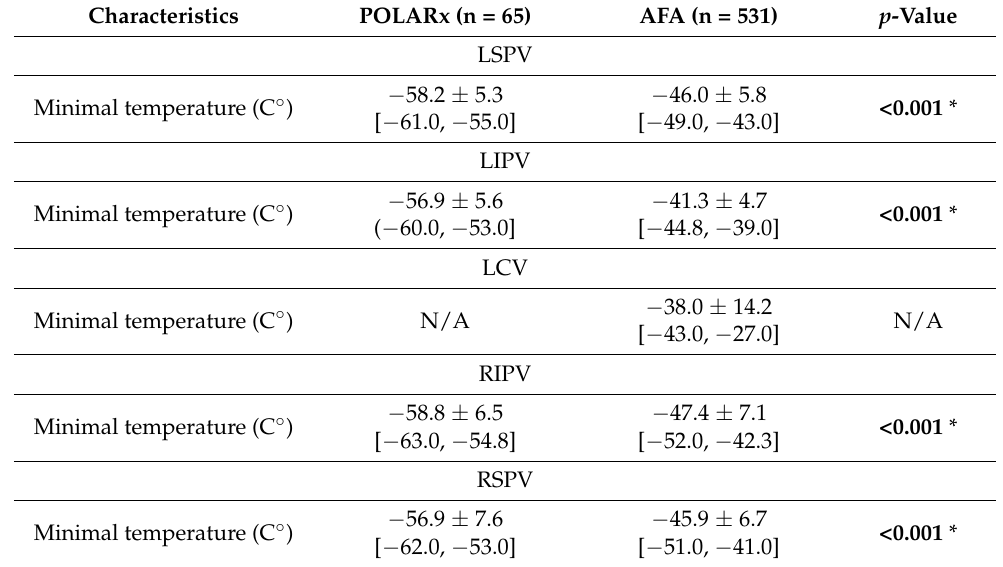
Table 5. Cryoablation freeze